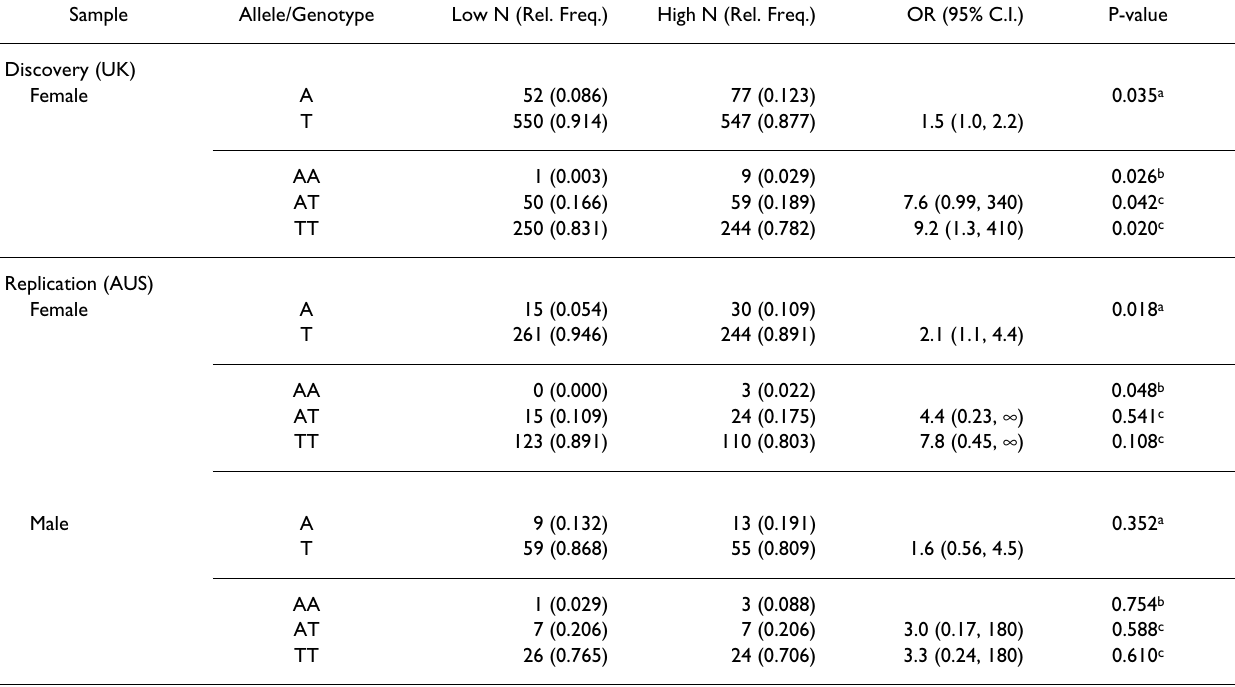
Table 2: Allele and genotype frequencies of rs1498608 in high and low lumbar spine BMD groups. Sample